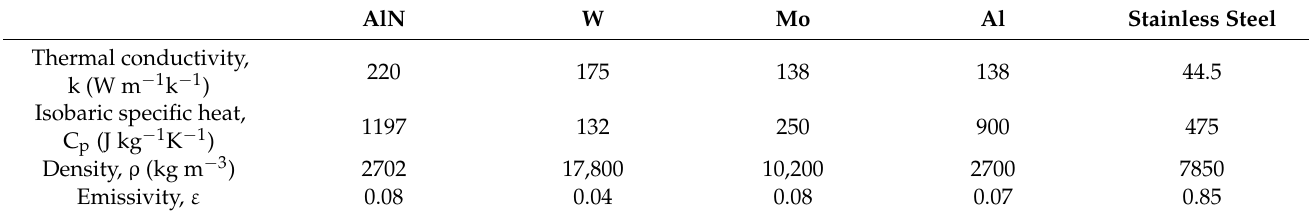
Table 1. Physical properties of the